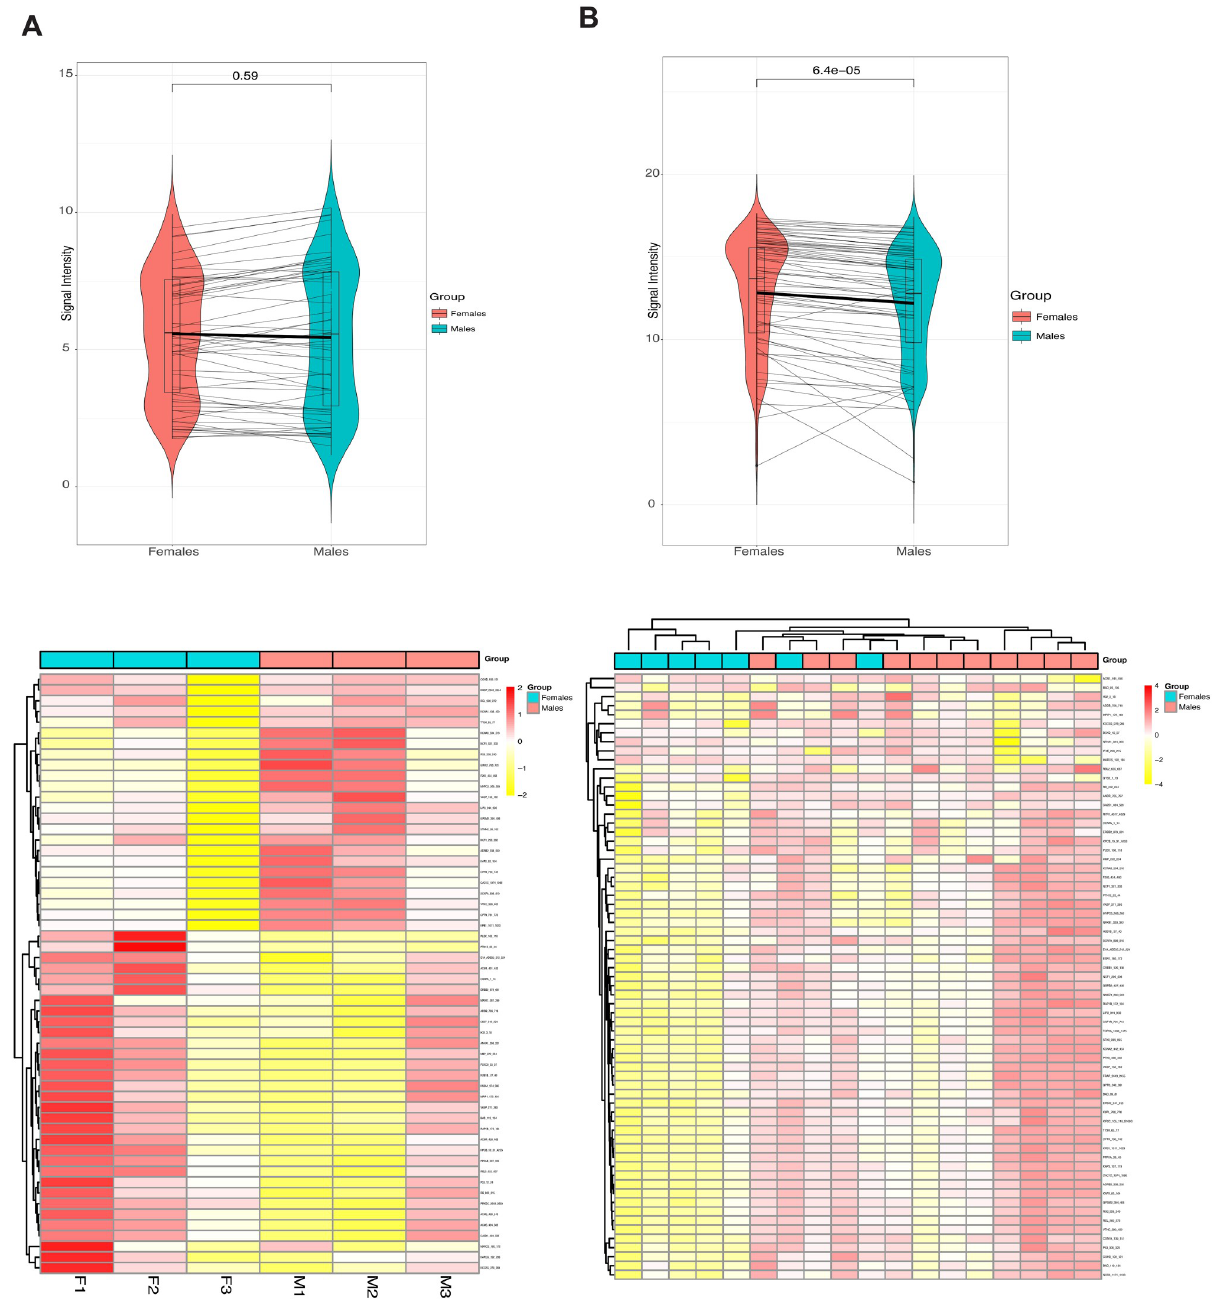
Fig 2. Global serine-threonine kinase activity in female vs. male DLPFC. (A) Global phosphorylation plots, showing signal intensity (phosphorylation levels) at each reporter peptide, as well as the average phosphorylation values (thick line), and a Mann-Whitney test when comparing females to males. A heatmap generated by KRSA depicting the relative signal intensity at each reporter peptide for the 6 samples on the array (3 females and 3 males) (B) Global phosphorylation plots, showing signal intensity (phosphorylation levels) at each reporter peptide, as well as the average phosphorylation values (thick line), and a Mann-Whitney test when comparing females to males using 18 control samples from the HPC cohort (11 females and 7 males). To highlight differences, the heatmap is normalized per row to present relative changes at each individual peptide between the groups. Red indicates relatively higher levels of phosphorylation and yellow indicates relatively lower levels of phosphorylation.